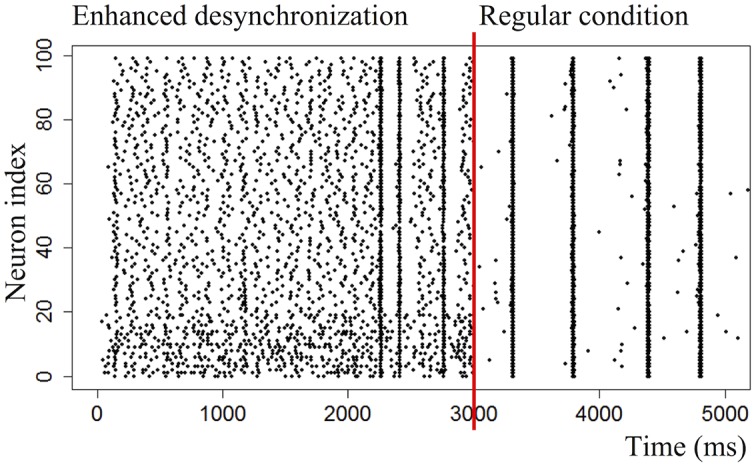
Raster plots of a regular network (activity concentrated in bursts) and a network of which parameters have been tuned to reduce bursting and enhance desynchronized spiking.The desynchronizing effect of sparsely connecting the network and increasing the noise are clearly visible.